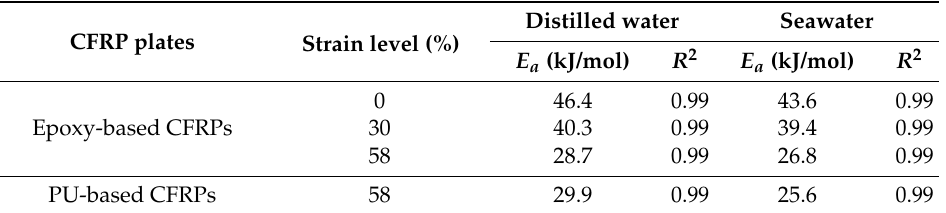
Table 4. Coefficients of regression equation in Equation (23).